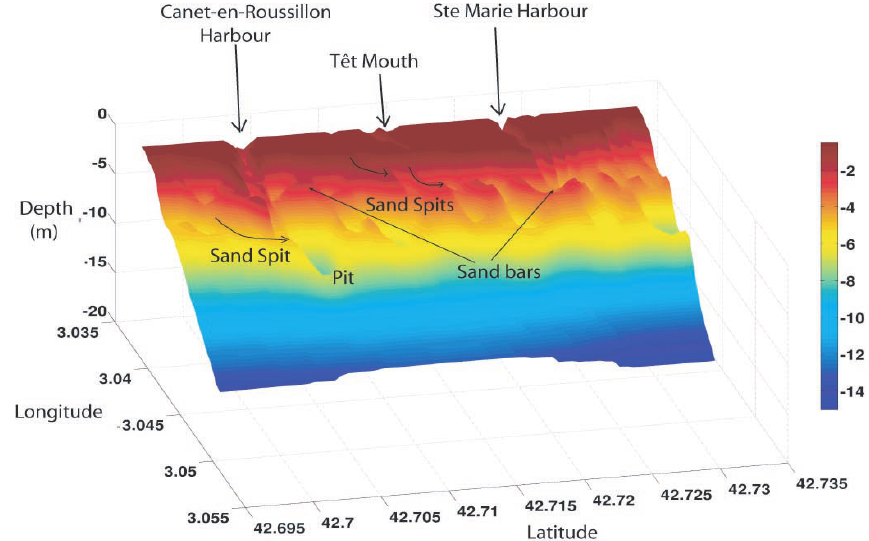
Fig. 8. The Tˆet bathymetry measured by the LiDAR survey. The distance between each measurements is 5m. The developments of northward sand spits in front of the river mouth or the Canet-en-Rousillon harbour are clearly visible.